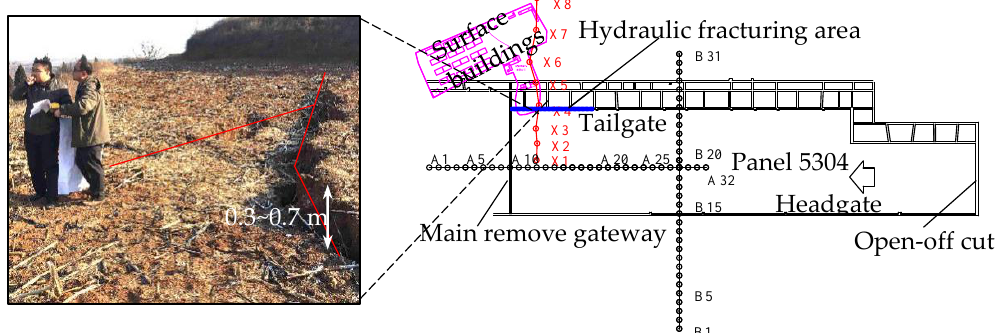
Figure 18. Surface stepped cracks at hydraulic fracturing area after mining.